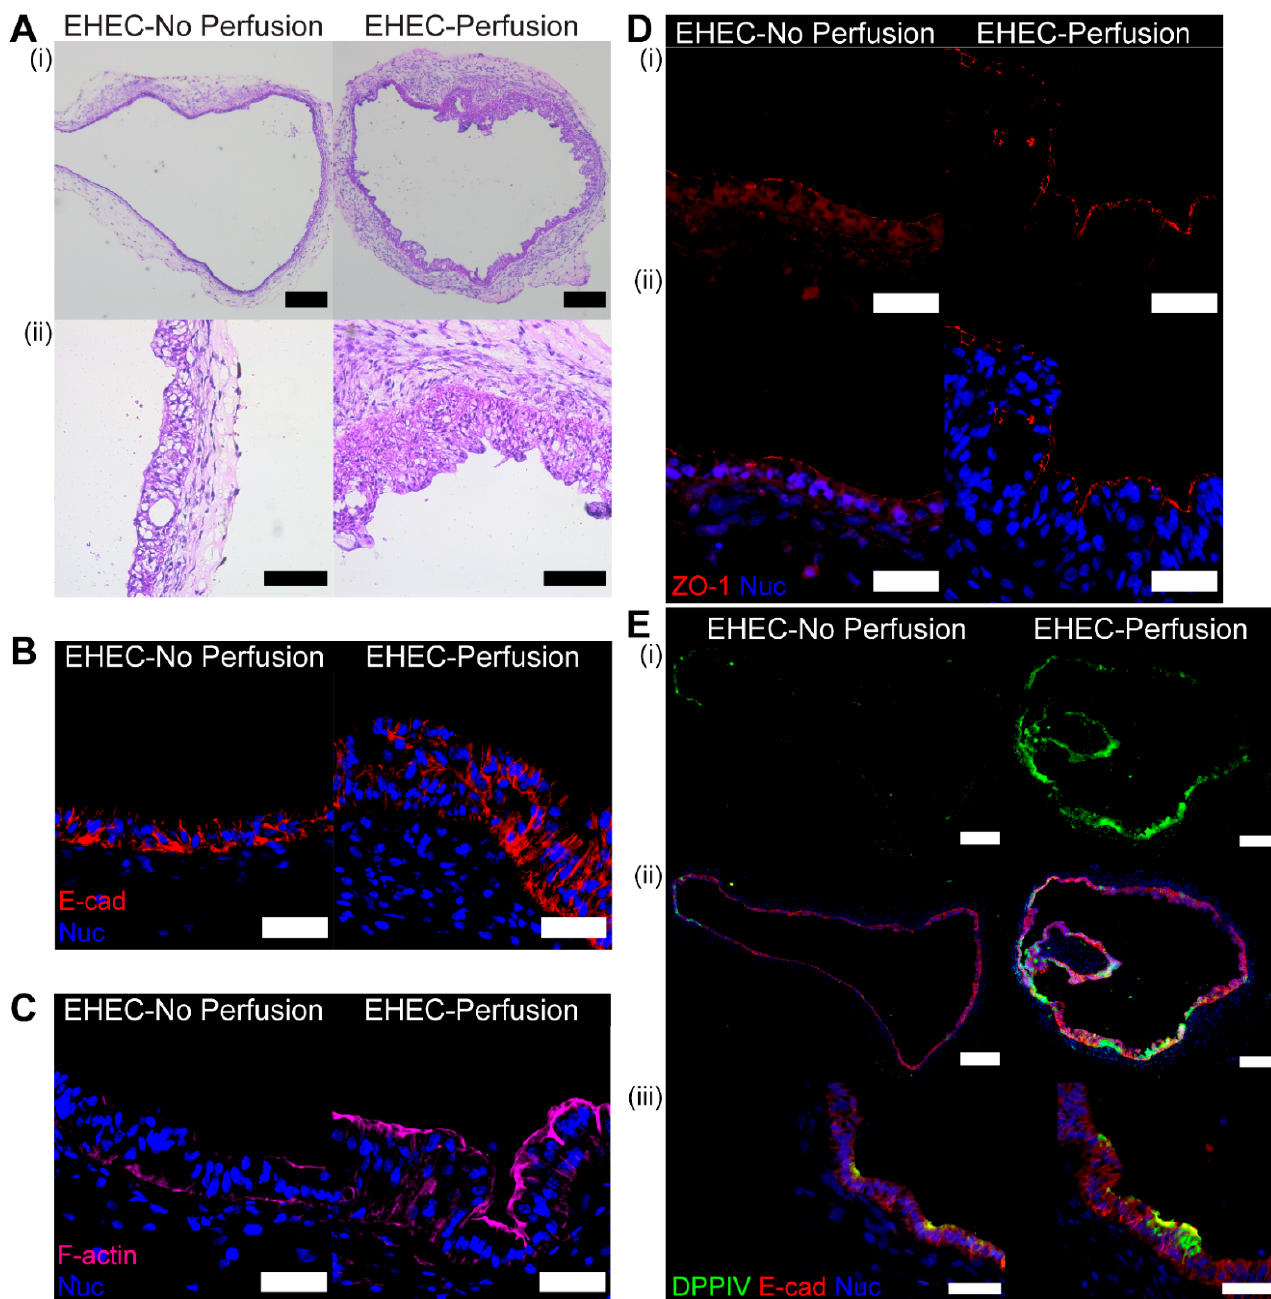
Figure 5. Immunostained cryosections of HIOs microinjected with enterohemorrhagic E. coli (EHEC) O157:H7. ( A ) H&E-stained sections of (left) unperfused HIOs and (right) perfused HIOs. Scale bars: (row i ) 250 µ m; (row ii ) 100 µ m. ( B – E ) Immunofluorescence-labeled cryosections of (left) unperfused HIOs and (right) perfused HIOs: ( B ) E-cadherin (red) and nuclei (blue); ( C ) F-actin (magenta) and nuclei (blue); ( D ) ZO-1 (red) and nuclei (blue). Row ( i ) shows only ZO-1 (red) and row ( ii ) overlays ZO-1 (red) and nuclei (blue); and ( E ) DPPIV (green), E-cadherin (red), and nuclei (blue). Scale bars: ( B – D ) 50 µ m, ( E , row i – ii ) 250 µ m, and ( E , row iii ) 50 µ m. E. coli O157:H7 is known to disrupt the intestinal epithelial barrier by remodeling actin filaments in the apical side and forming the locus of an enterocyte effacement (LEE) pathogenicity island. HIOs challenged with E. coli O157:H7 lose epithelial